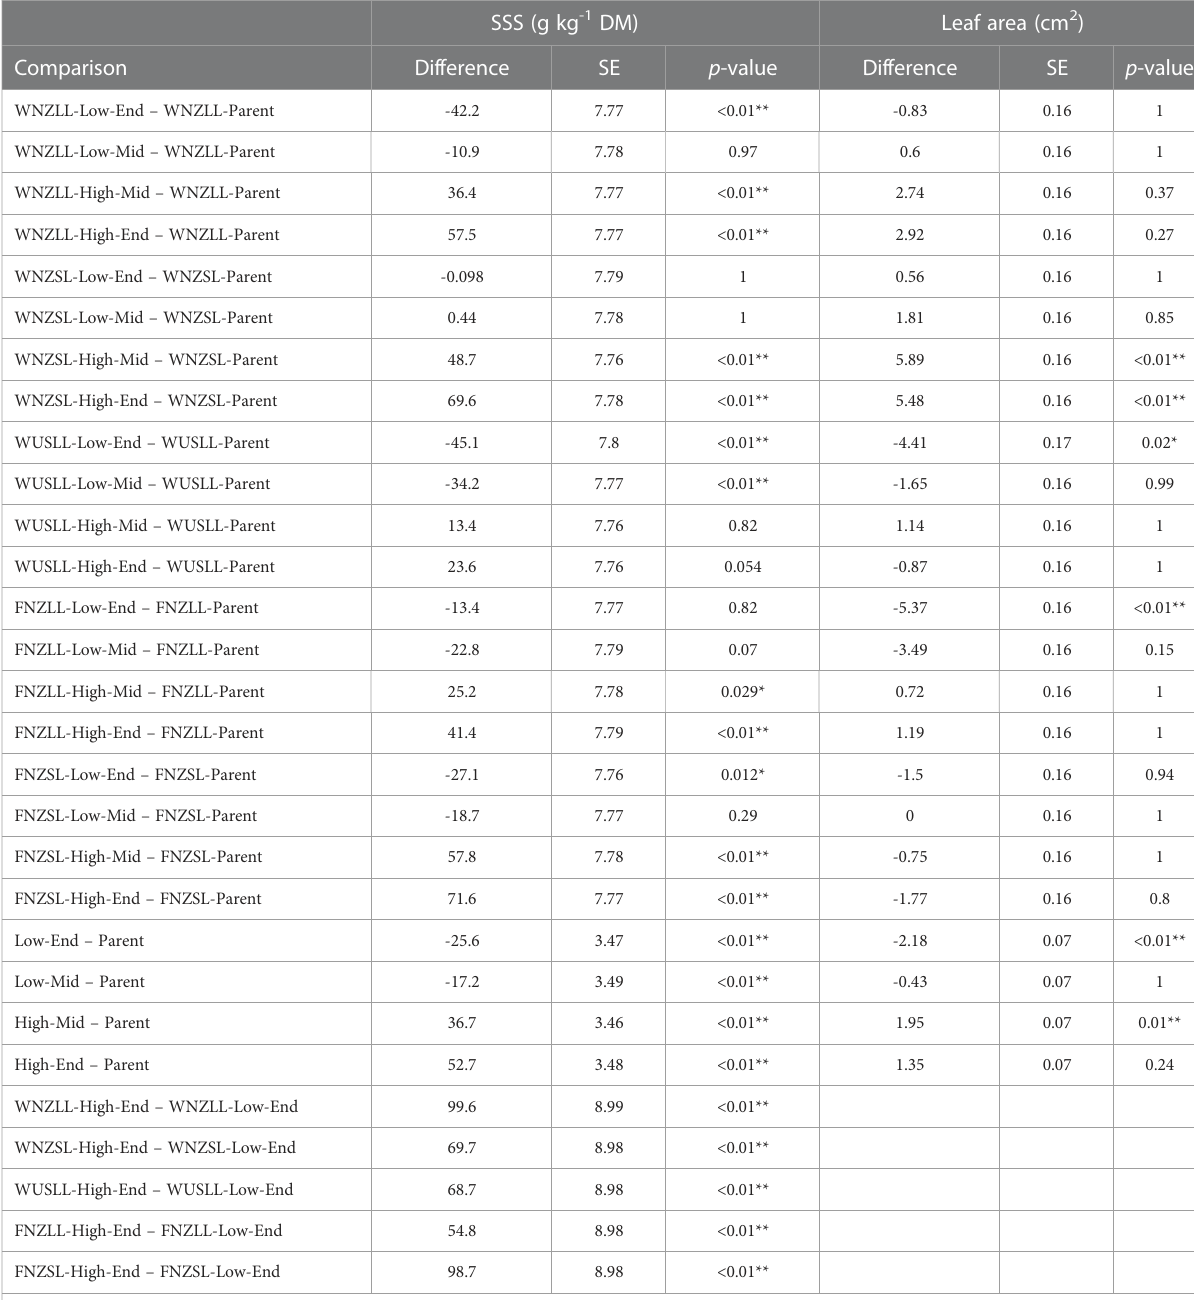
TABLE 1 Estimated phenotype means for each divergently-selected population compared to the parental mean after adjusting for treatment, block, row and column effects.